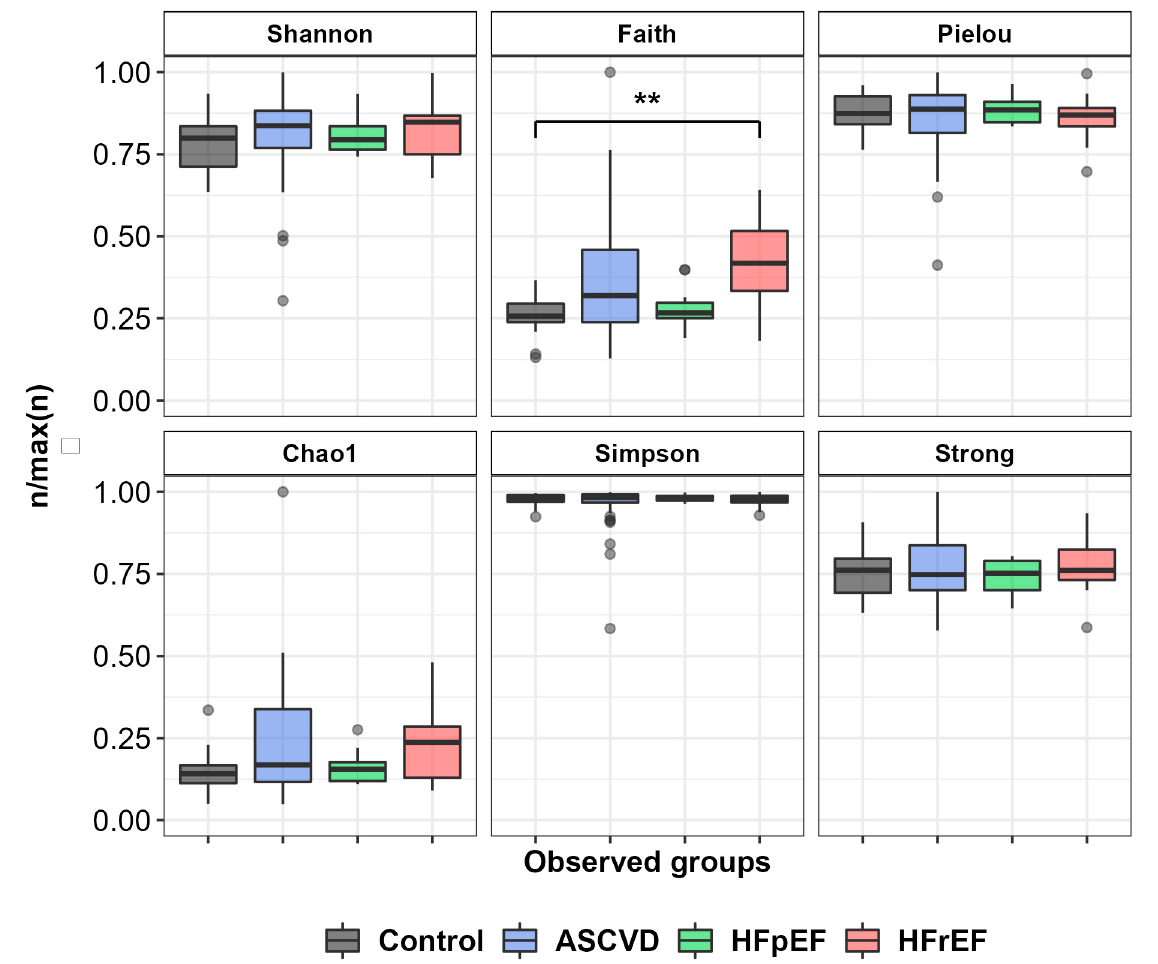
Figure 3. Analysis of alpha diversity of samples’ microbiome. ** indicates p < 0.01.